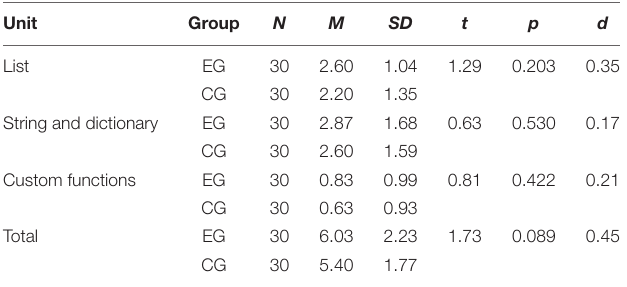
TABLE 9 | The independent sample t -test of the two groups’ program correction questions in the unit test.